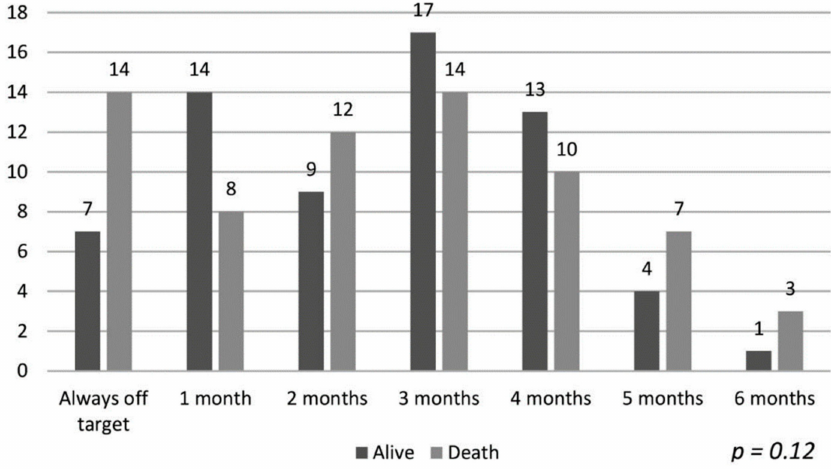
Figure 1. Target hemoglobin time and